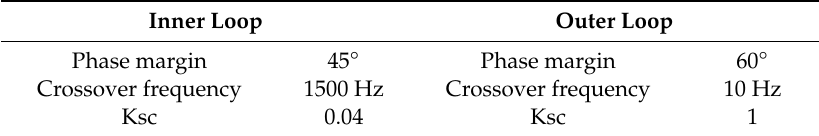
Figure 12. Driving profile ECE-15.